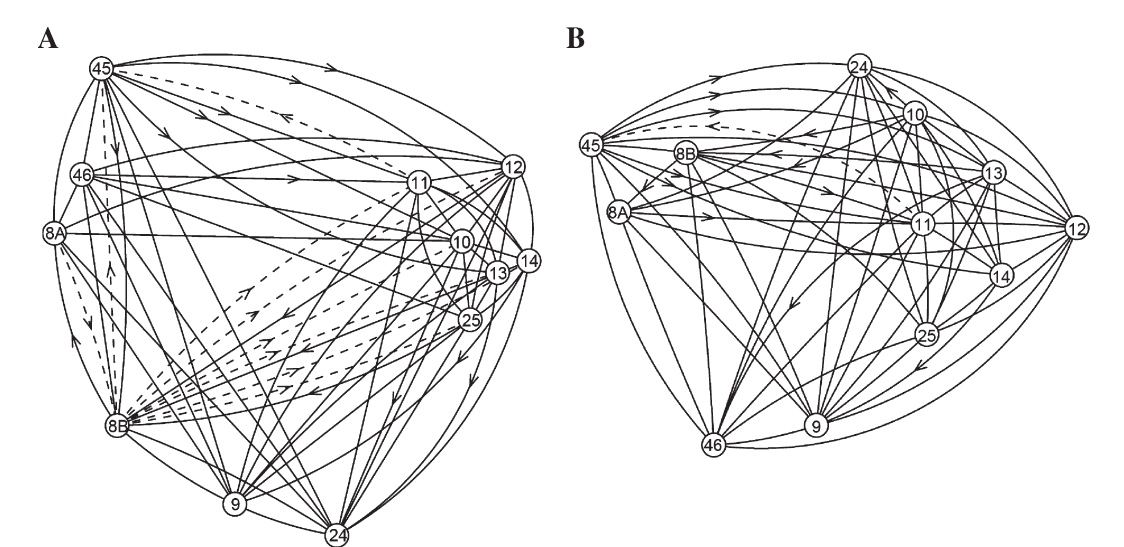
Figure 3. Diagram portraying the directed graphs representing the prefrontal interregional cortical network. ( A ) Original W40-0 and W40-1 networks as analyzed in previous studies (Ko¨tter and Stephan, 2003; Passingham et al., 2002; Stephan et al., 2001); ( B ) W40-2 network. The positions of nodes were obtained by MDS (see legend to Figure 1 ). The dashed lines indicate connections whose status of existence was